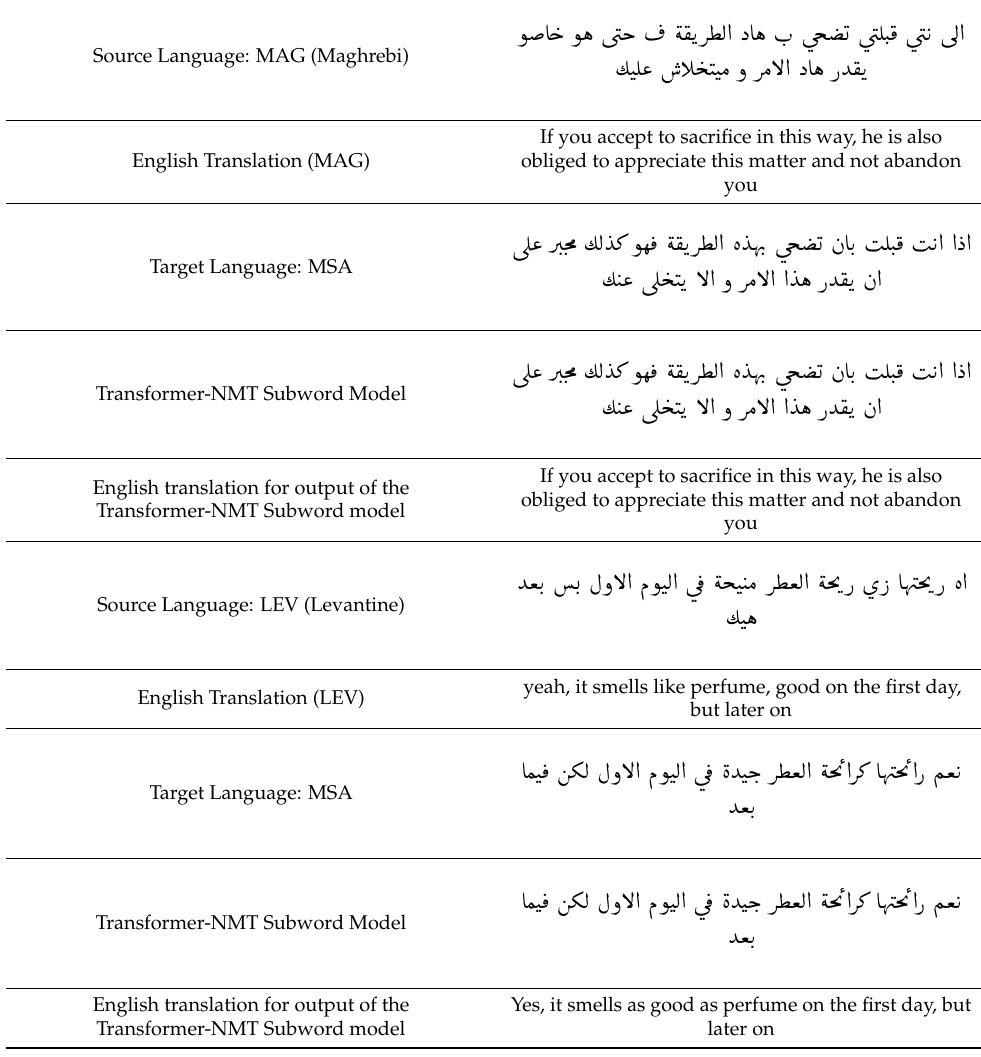
Table 12. Translation Examples for Maghrebi Arabic and Levantine Arabic, Baniata [22]